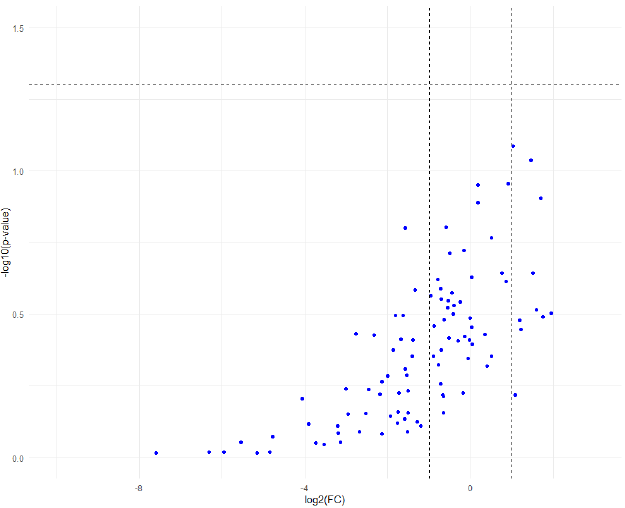
Figure 6. Volcano plot representing metabolite dysregulations between control and sonoporation groups, with thresholds set at log2FC < − 1 or >1, and − log10( p -value) > 1.30 ( p < 0.05). The vertical dotted bars represent the log2FC thresholds at − 1 and 1. As all metabolites were under the horizontal dotted line, none of the expression variations were significant. The graph was similar using the FDR adjusted p -value.